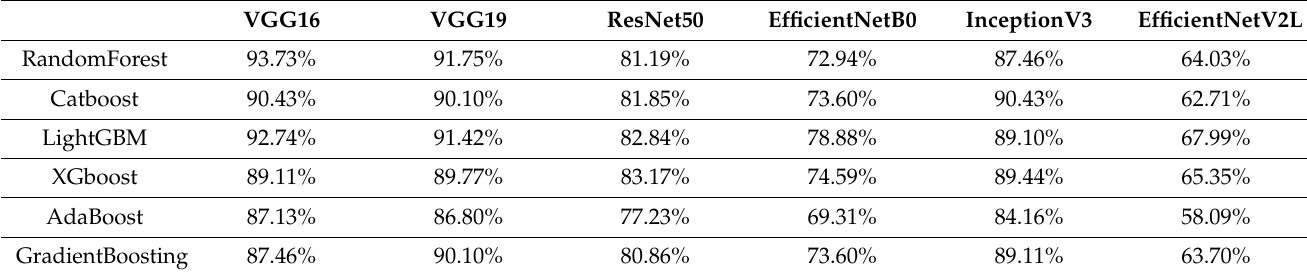
Table A21. Accuracy of each model combination for all blue-colored geometries.